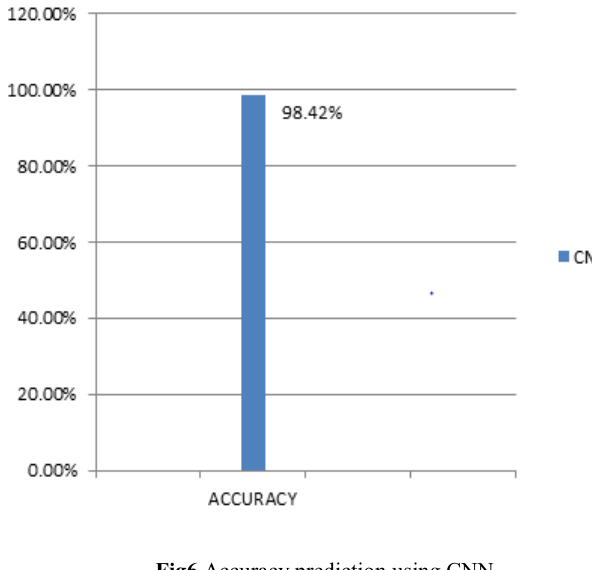
Fig6. Accuracy prediction using CNN.